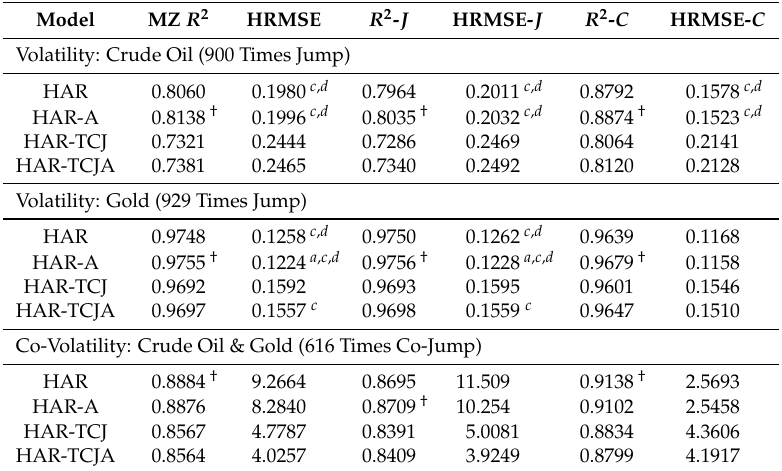
Table 6. Out-of-sample forecast evaluation for weekly regressions.